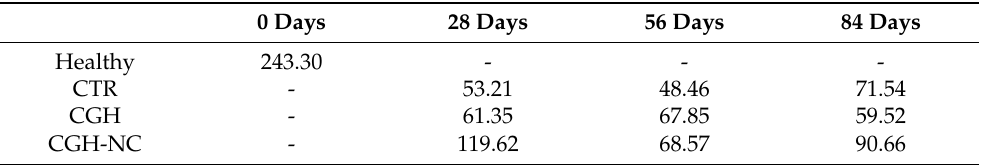
Figure 9. Hyaluronic acid concentration whiskers plot box for the three treatment groups at the three different survival times. * shows significant differences compared to the remaining groups ( p < 0.05). Table 1. HA synovial fluid concentration ng/mL. * ( p < 0.05). Units are stated in ng/mL due to the HA concentration obtained following methodology used by Liu et al. (2016) [37].